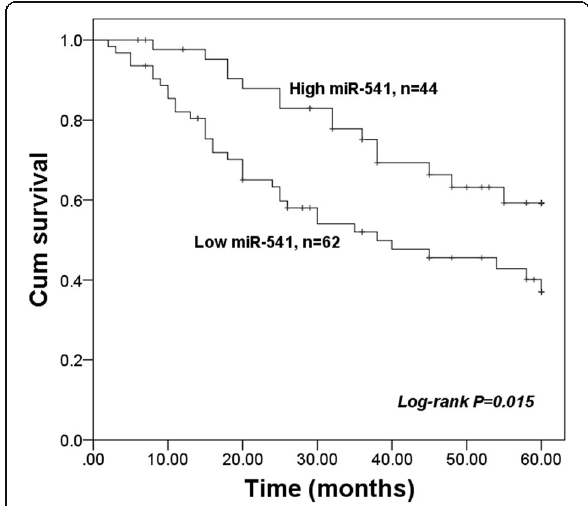
Fig. 2 Survival curves for OS patients constructed by the Kaplan- Meier method. Patients with low miR-541 expression had a shorter survival time compared with those with high miR-541 expression. Log-rank P = 0.015